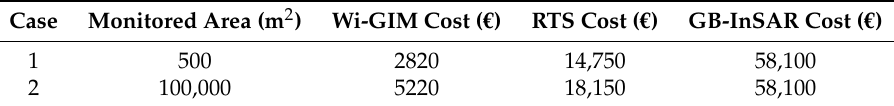
Table 8. Wi-GIM System Cost Analysis.